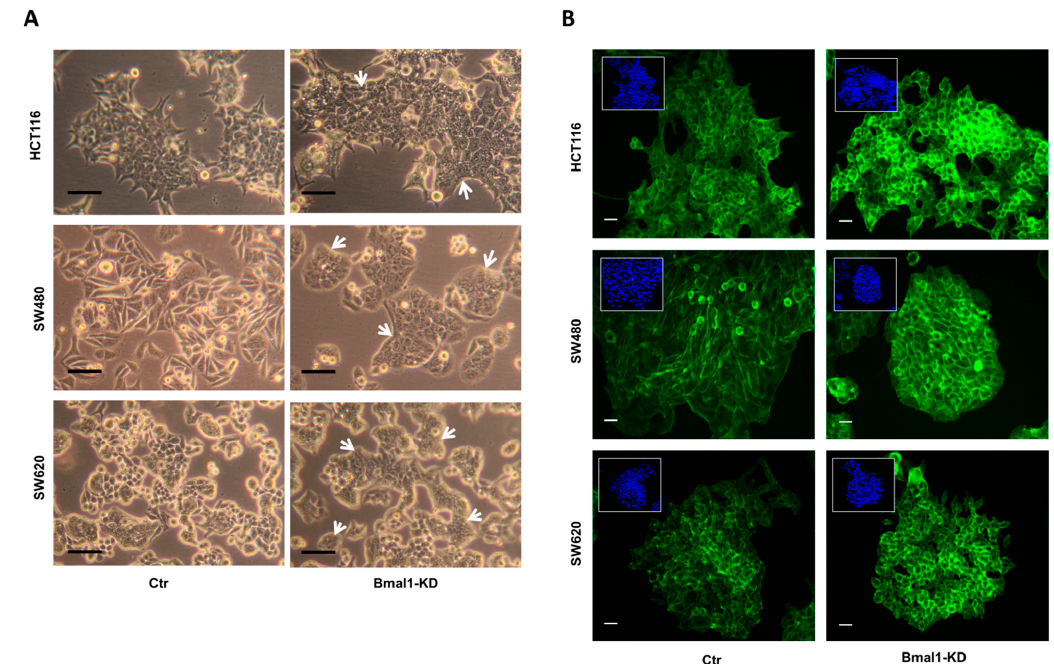
Figure 4. BMAL1-KD induced morphological changes on CRC cell lines . ( A ) Cells were viewed using phase contrast microscopy at the objective 20×. Compared to the control (Ctr) cells, CRC cells formed densely packed clones in the three BMAL1-KD CRC cell lines (white arrows). Morphological changes were most prominent in SW480 BMAL1-KD cells, with loss of an elongated and spindle-shaped morphology and acquisition of a typical epithelial shape with a cobblestone-like morphology. Scale bars, 50 μ m. ( B ) F-actin distribution profile was analyzed by fluorescence microscopy with phalloidin (green). Nuclei staining with DAPI (blue) was inserted at the top-left of each image. Scale bars, 15 μ m. The F-actin distribution profile was similar to those of E-cadherin and β -catenin in BMAL1-KD CRC cells, revealing a specific honeycomb-like epithelial organization of the adhesion belts delineated by E-cadherin, β -catenin, and F-actin.